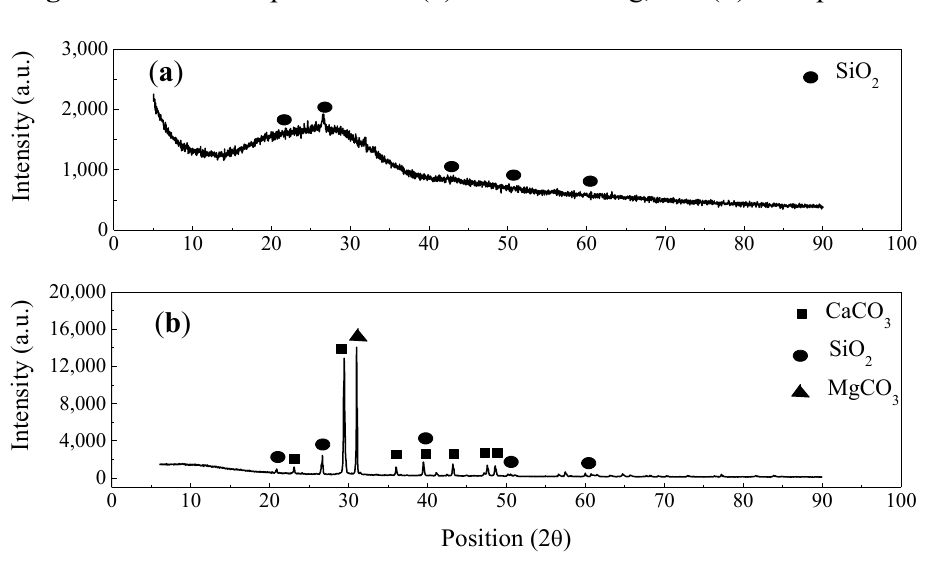
Figure 1. Phase compositions of ( a ) enamel coating, and ( b ) sand